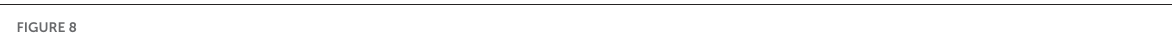
FIGURE8 detected by one-step fluorescent qPCR. (E,F) RT-qPCR detection of mitochondrial-related genes including NRF1 and Tfam . qPCR was used to detect the expression of adipogenesis-related genes (G,H) , lipid synthesis-related genes (I,J) and lipolysis-related genes (K,L) . (M) The expression of lipolysis-related proteins, ATGL, HSL, and P-HSL (s660) was detected by western blotting under basal and Fsk stimulation. (N) Glycerol content was normalized to the total amount of protein in each sample in the Oe-NC and Oe-circOgdh groups under the basal and Fsk stimulation. All values presented are the mean ± SEM ( n = 3), * P < 0.05, ** P < 0.01, *** P < 0.001, NS, Not Statistically